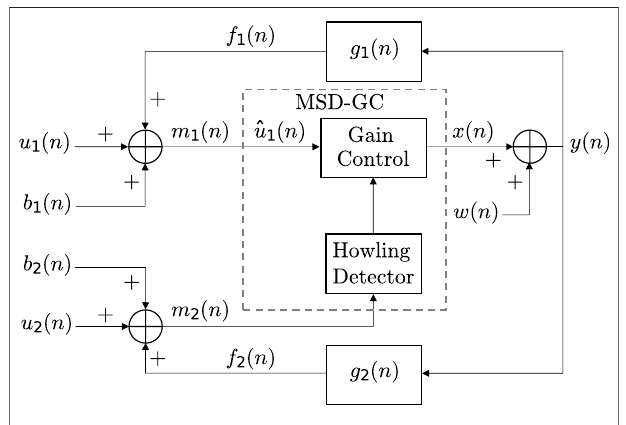
FIGURE 3 | Proposed MSD-GC algorithm within the proposed dual- microphone system (the SR-segment is empty). The howling detection algorithmisbasedontheMSDmeasure,andcontrolstheampli fi cation-gainof the system within the proposed gain-control segment (i.e., MSD-GC).